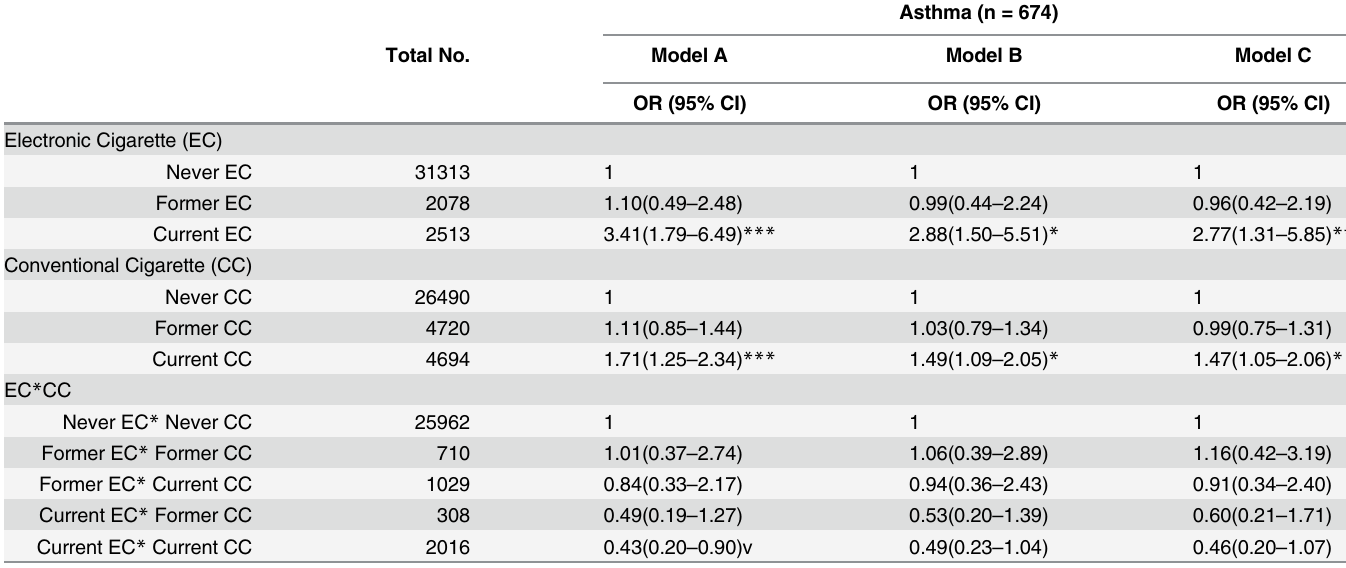
Table 5. Results of multiple logistic regression analyses with interaction term for EC * CC among high school students in Korea.